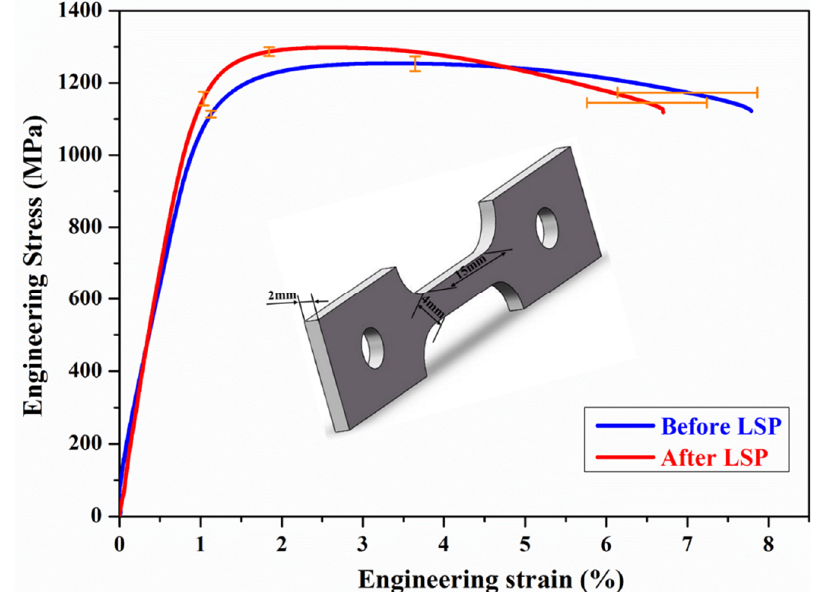
Table 2. Tensile properties of SLM-fabricated Ti64 samples before and after LSP.